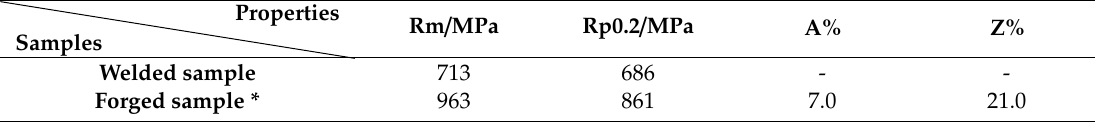
Table 3. Tensile properties of the welded and forged